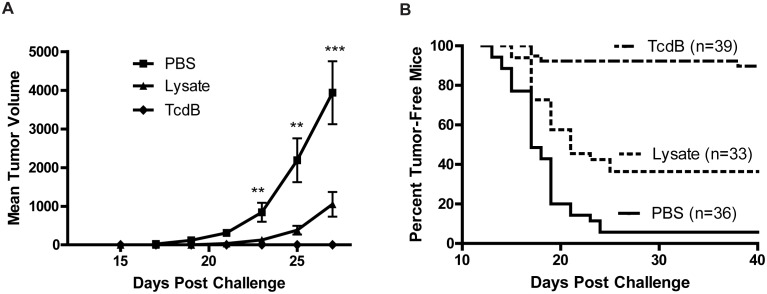
Anti-tumor immunity induced by dying CT26 cells.Mice were subcutaneously immunized with PBS or TcdB-exposed CT26 cells (TcdB). In some experiments, mice were injected with lysate of TcdB-treated CT26 cells (TcdB-lysate). Mice were then challenged with 105 live CT26 cells on the opposite side of the groin and tumor growth was monitored. (A) Tumor volume was calculated using the formula: length×width2×π/6. The data represent one of five independent experiments (n = 5∼8). **, P<0.01 vs. PBS; ***, P<0.001 vs. PBS (paired two-tailed t-test). Error bars, SEM. (B) The percentage of tumor-free mice was measured. The data in (B) represent a pool from five independent experiments (n = 5∼8 for each experiment).